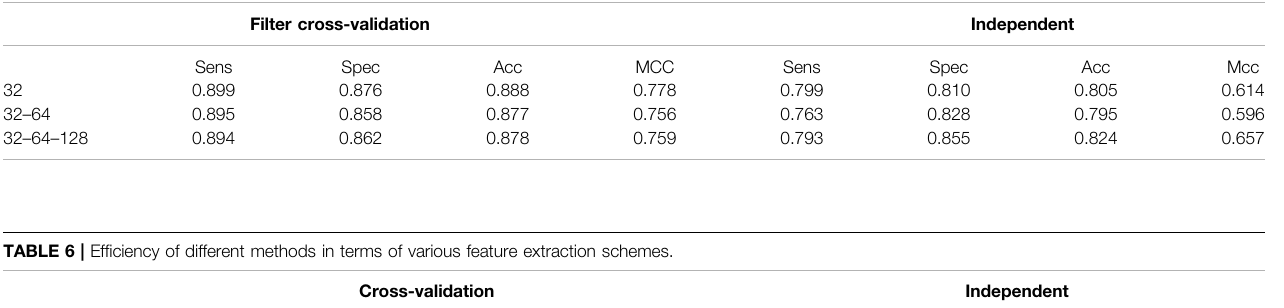
TABLE 5 | Comparison with different fi lters.